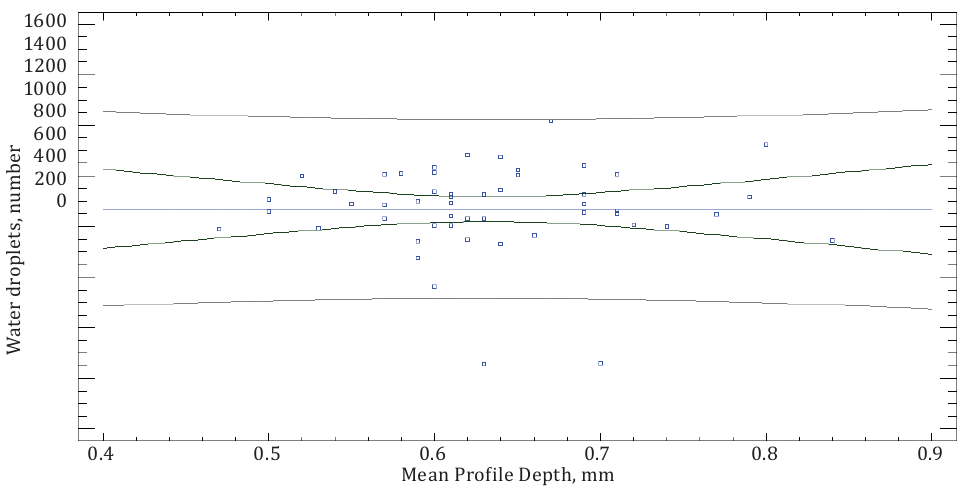
Plot of Fitted Model Water droplets T2 = 872.255 – 5.01961 × MPD